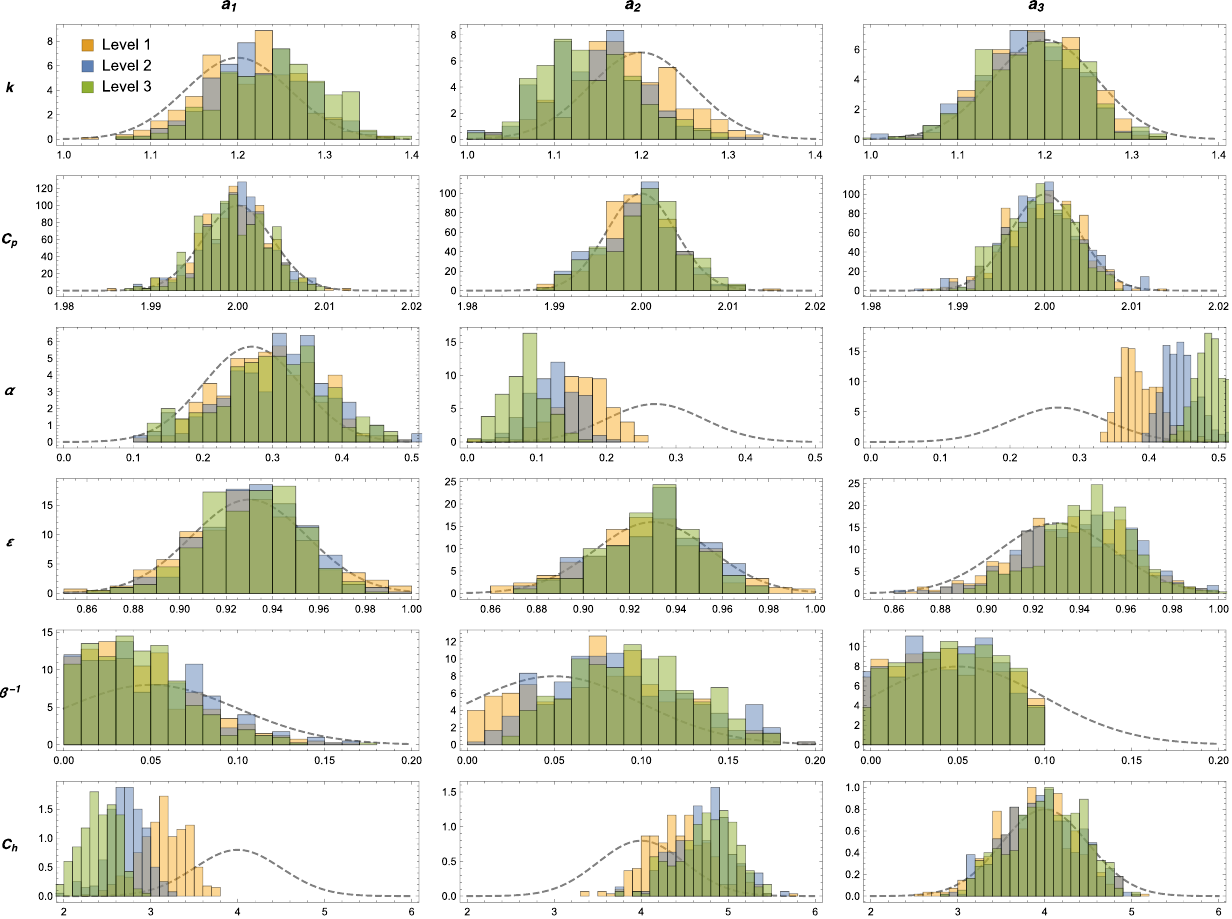
Figure 1. Histograms of conditional samples at different conditional levels for surface property parameters (rows from top: thermal conduc- tivity k in Wm − 1 K − 1 , heat capacity C p in MJm − 3 K − 1 , albedo α , emissivity ε , inverse Bowen ratio β − 1 , and bulk transfer coefficient C h in Jm − 3 K − 1 ) with AnOHM coefficients as the model output (columns from left: a 1 , a 2 and a 3 ) . Each subplot x axis is the parameter value and y axis is the PDF value. The original proposal distribution (dashed line) and simulation levels (different colours) are shown.